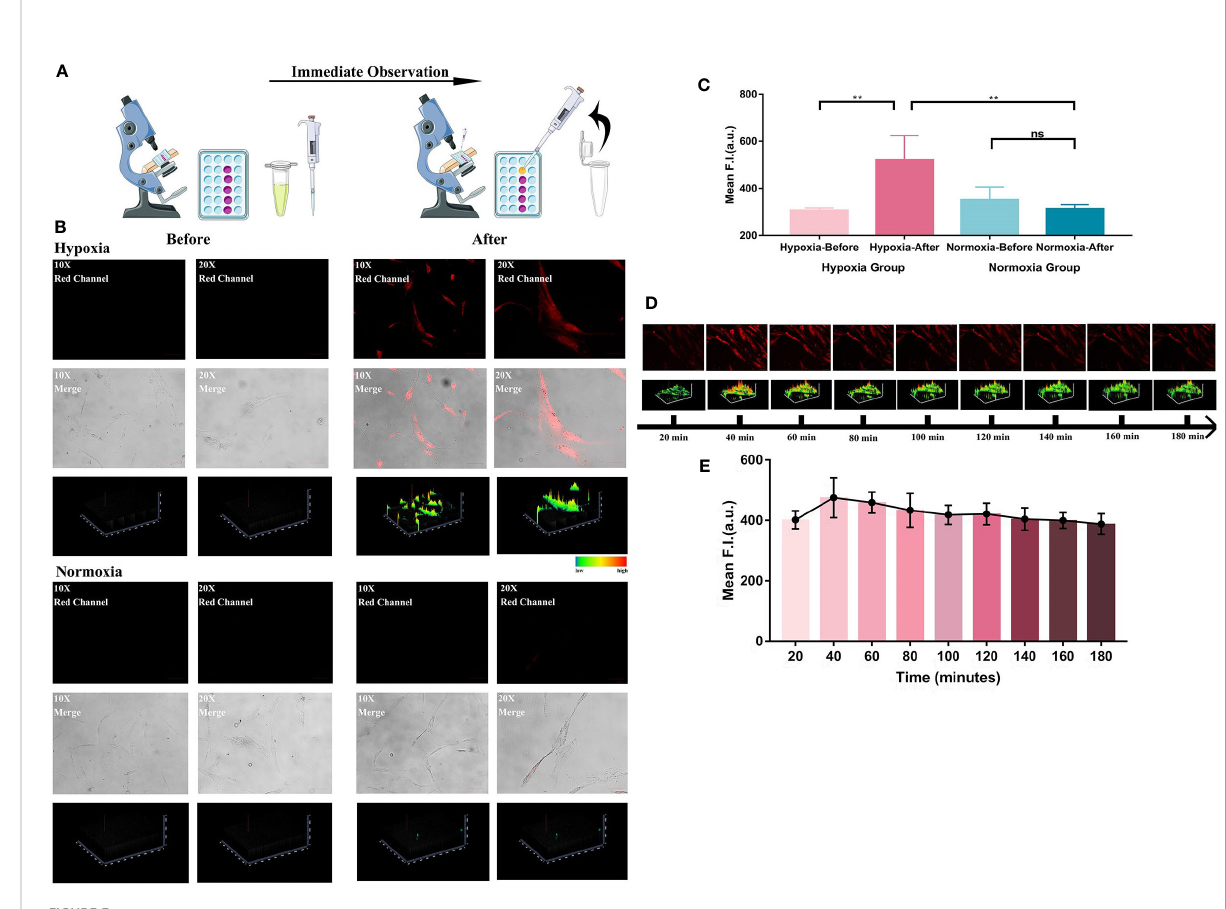
FIGURE 3 (A) Systematic illustration of the process of immediate response test. Both hypoxia group and normoxia group were fi rstly observed in the microscope before the treatment of HNT-NTR. After adding HNT-NTR, the cells in the same locations were then observed again